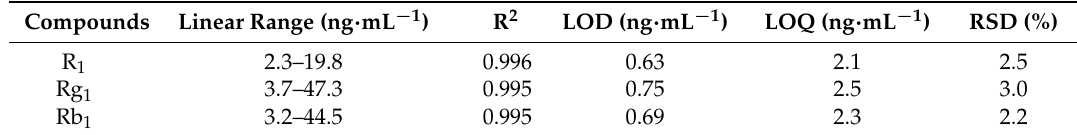
Table 3. The performance parameters of the proposed method ( n =